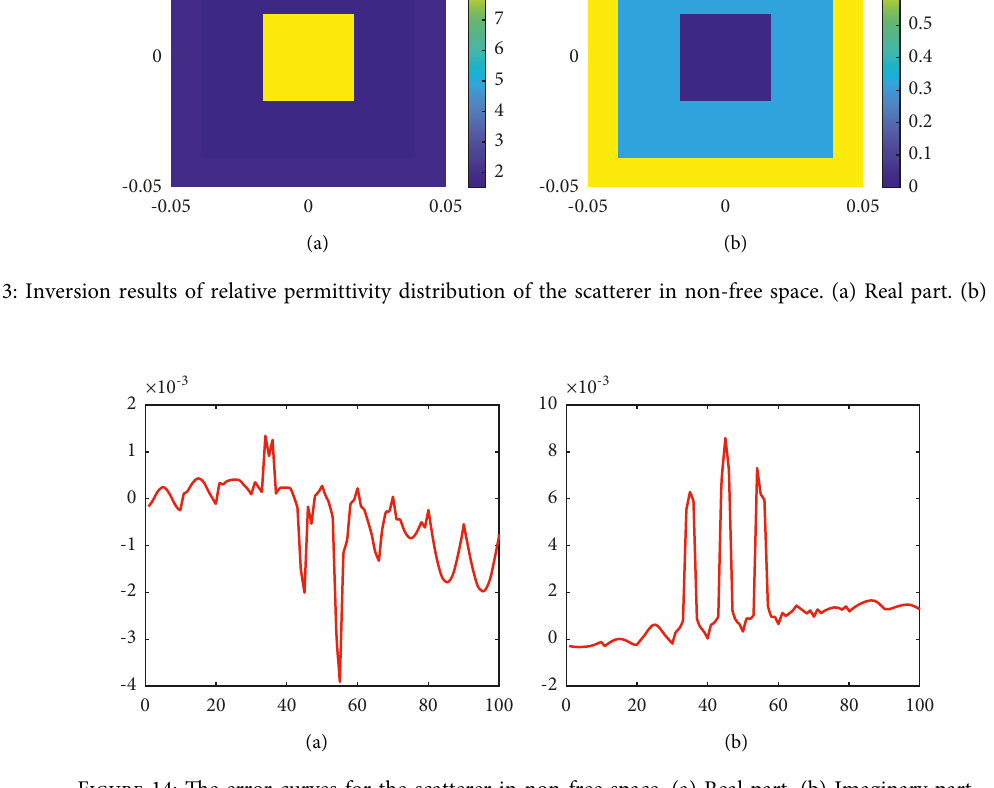
Figure 14: The error curves for the scatterer in non-free space. (a) Real part. (b) Imaginary